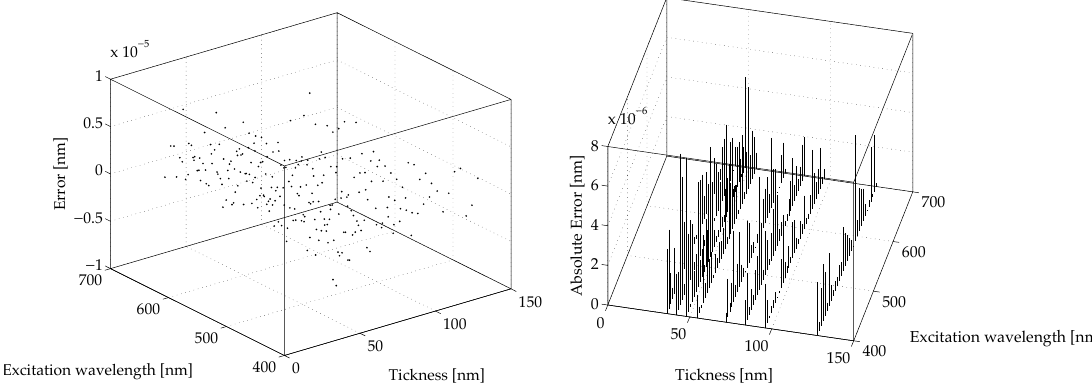
Figure 6. The obtained results: the model error E λ Equation (11). The ( left ) shows the prediction error for λ SPP and the ( right ) shows its absolute